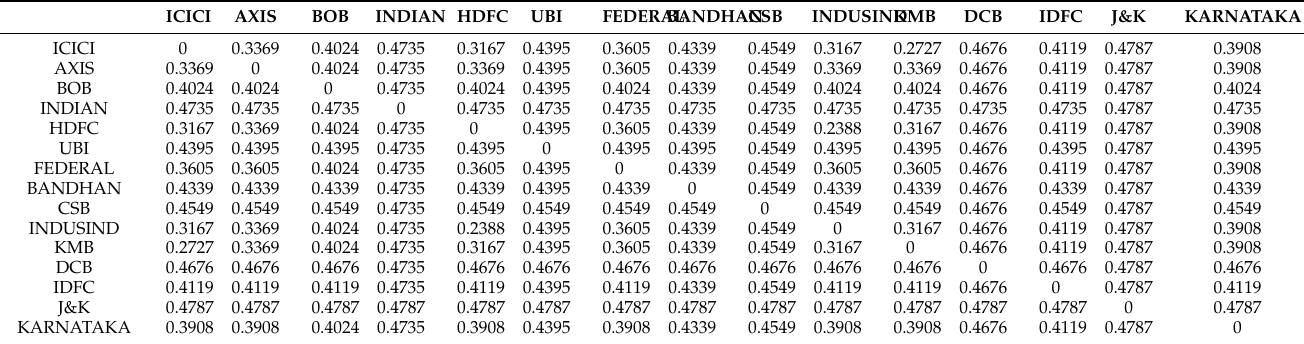
Table 7. Adjacency matrix of the strength of connectedness (last component).